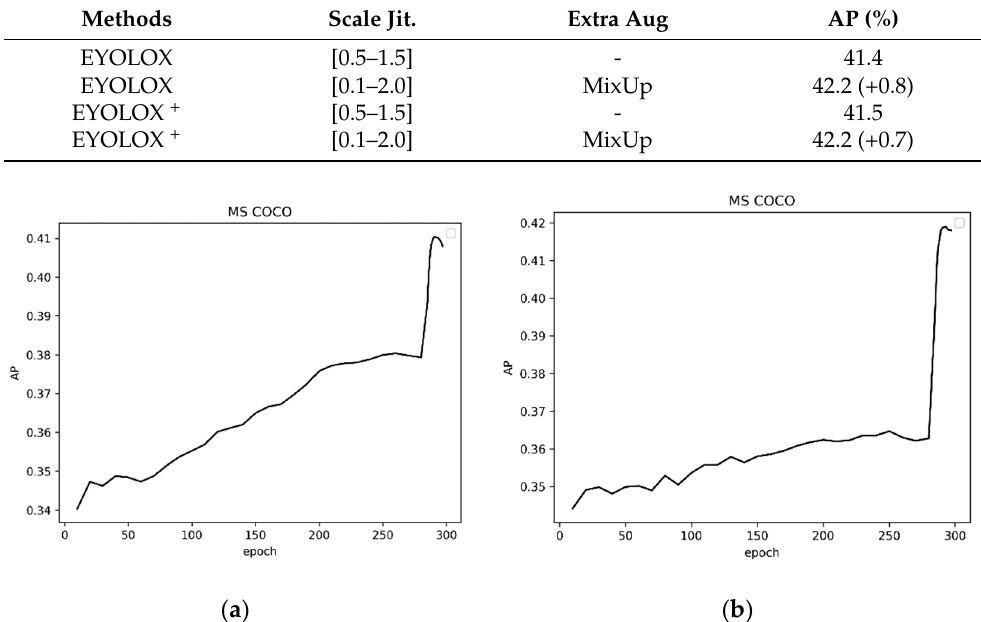
Table 4. Comparison of the accuracy of different object detectors on COCO-2017 val. The methods marked with “*” are the results reproduced in other papers. Without the associated annotations, all our results are derived under 300 epochs.